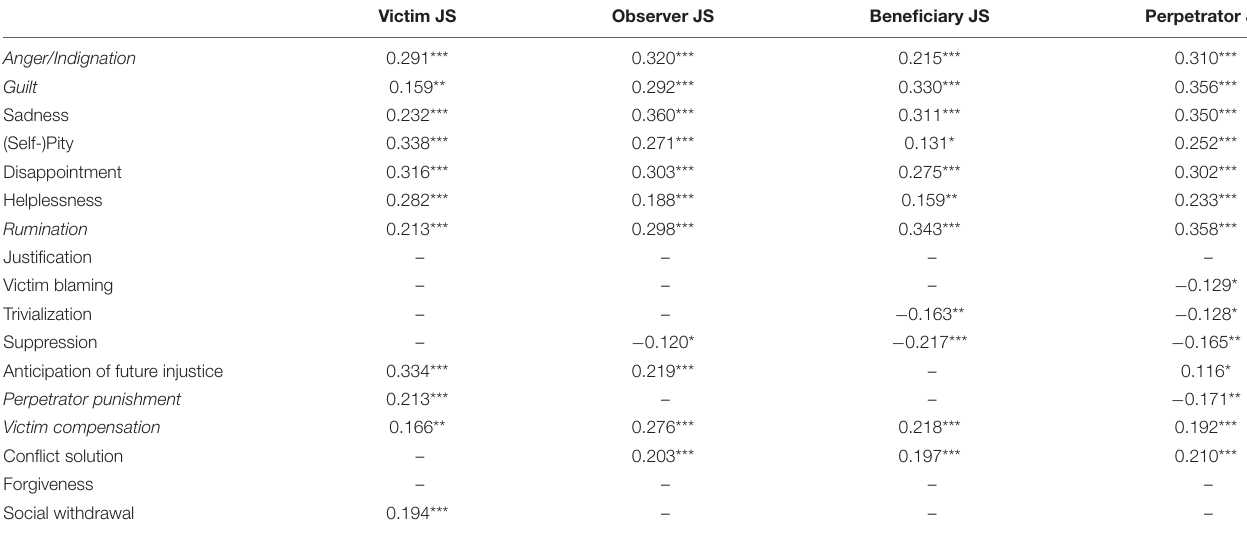
TABLE 4 | Zero-order correlations between JS facets and responses to injustice averaged across all 12 unjust